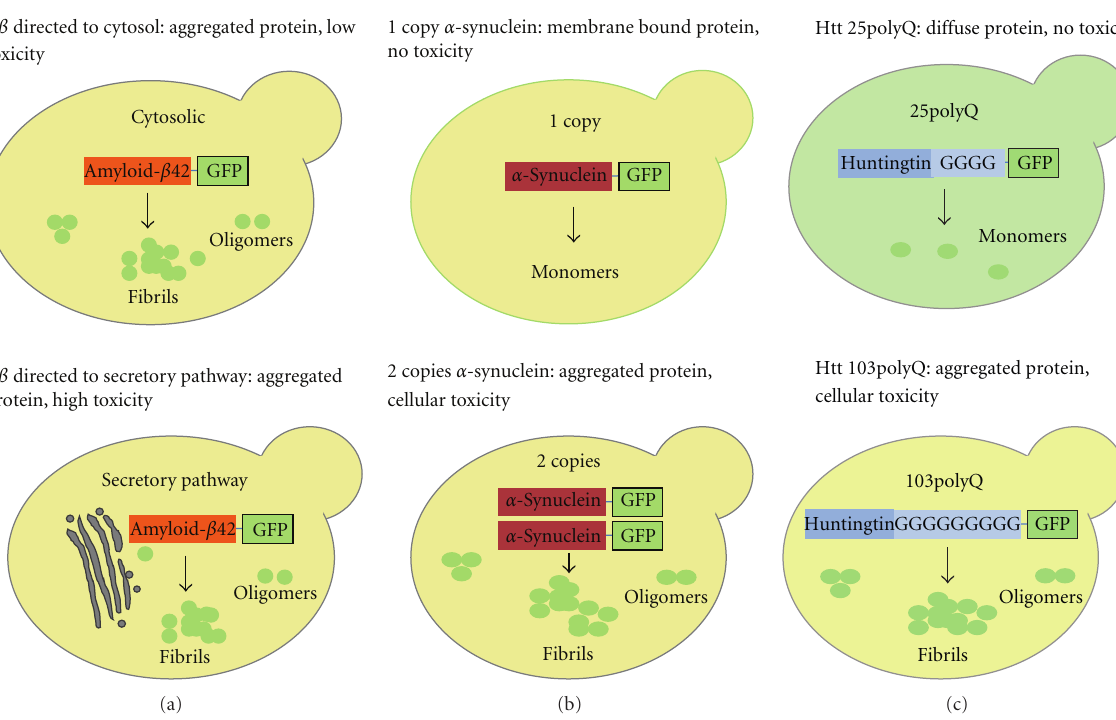
Figure 1: Yeast models of (a) AD, based on amyloid- β 42 expression; (b) PD, based on α -synuclein expression; (c) HD, based on Huntingtin’s polyQ tract expression. (a) The toxic A β 42 peptide expressed in yeast causes aggregation and moderate stress, but when expression is directed to the secretory pathway, the toxicity is increased. (b) At low expression levels, α -synuclein associates with the plasma membrane with no e ff ect on cell viability. At doubling expression levels, α -synuclein redistributes from the cell surface into aggregates and induces toxicity. (c) Expression of a Huntingtin polyQ tract with 25 glutamines (normal length) does not lead to aggregation or toxicity. Expression of a polyQ tract with 103 glutamines (HD-associated expansion) leads to the formation of aggregates and toxicity (dependent on the presence of active